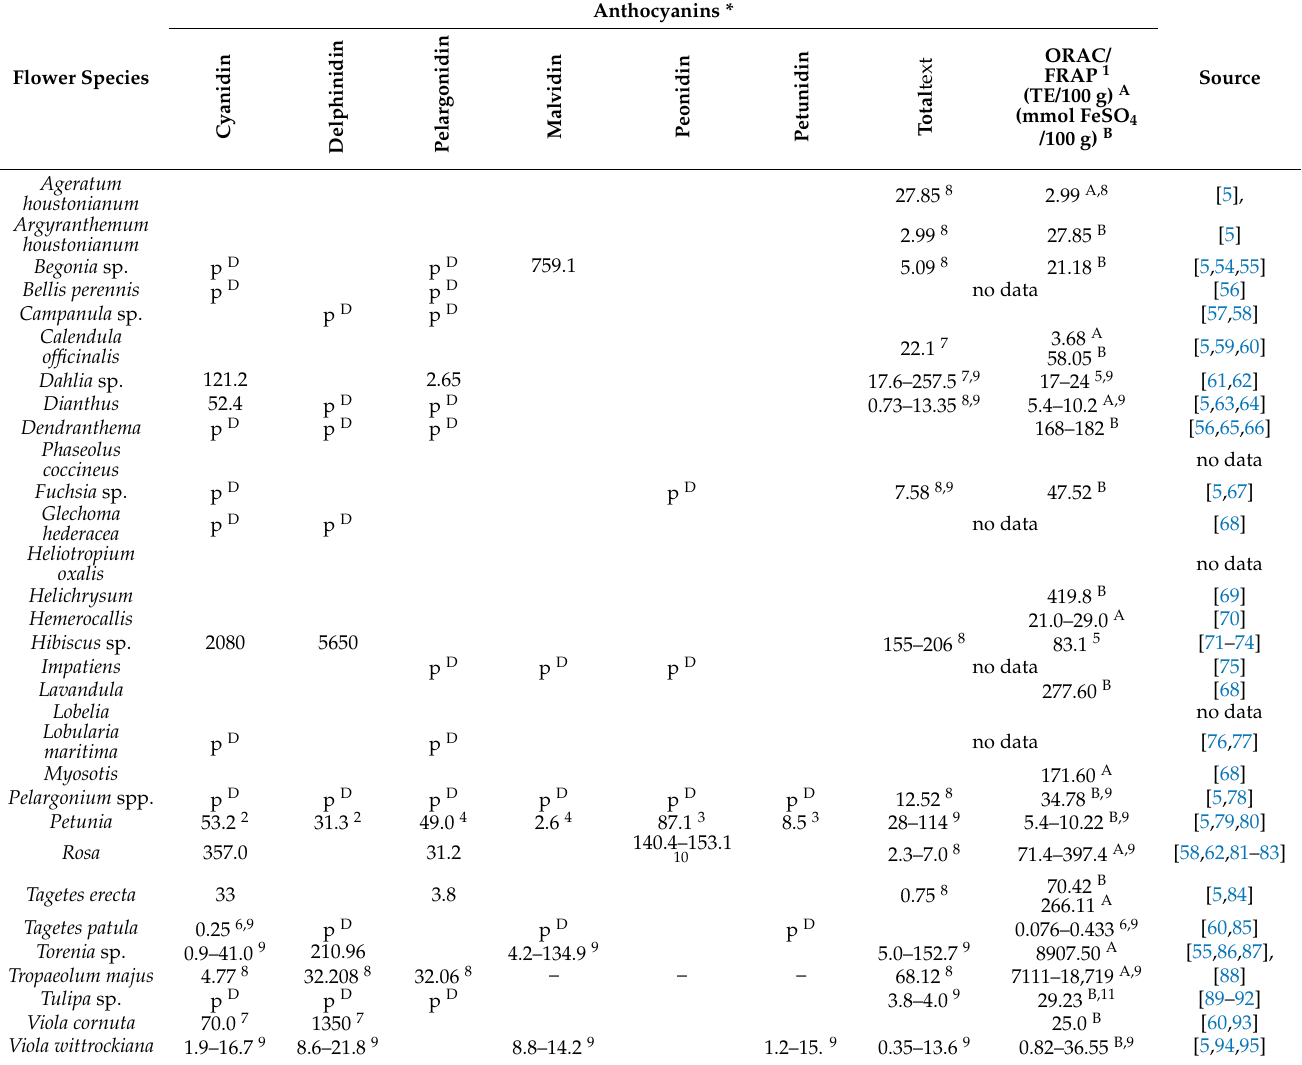
Table 1. Anthocyanin content in edible flowers grown in